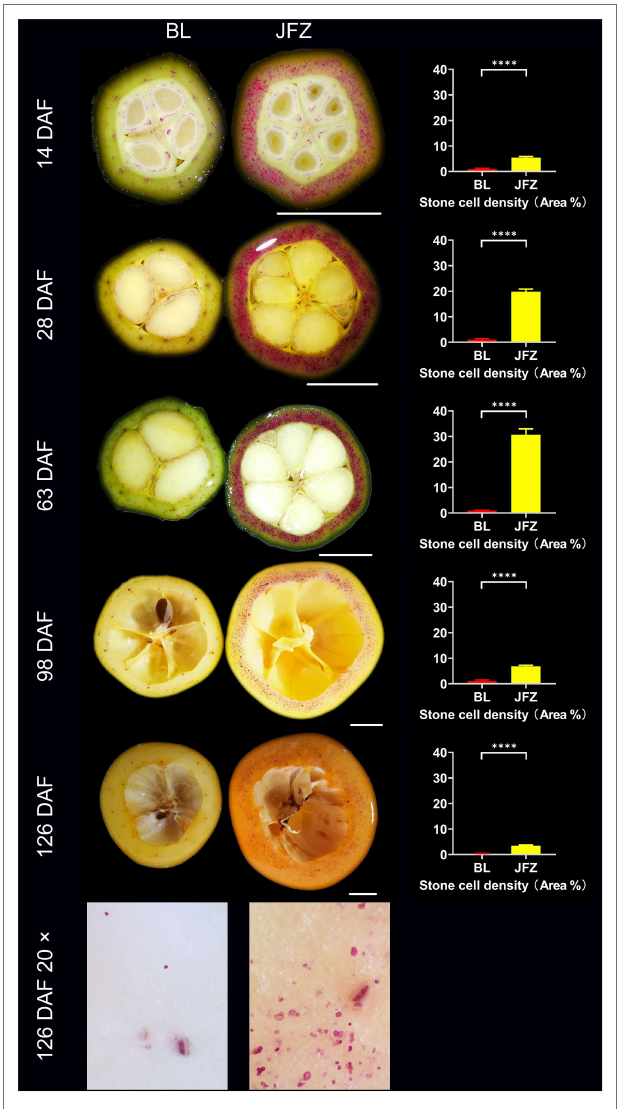
FIGURE 5 | Phloroglucinol-HCl staining and microscopic observation of transverse sections of fruit pulp from white and yellow loquat fruits. DAF: Days after full bloom; BL: White-fleshed loquat fruit ( Eriobotrya japonica Lindl. cv. Baili); JFZ: Yellow-fleshed loquat fruit ( Eriobotrya japonica Lindl. cv. Jiefangzhong); and 20×: 20× stereoscopic microscopy observations. Bar charts show the stone cell density; “****” represents value of p <